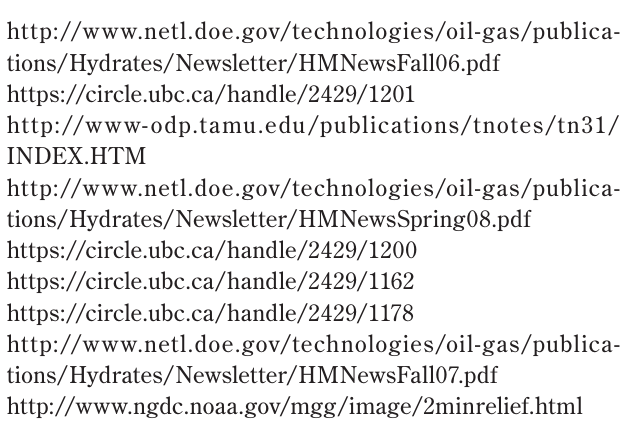
Fig. 3: N. Wu, GMGS. (Currently at GIEC, Guangzhou Fig. 4: J. -H. Chun, KIGAM Fig. 5: P.